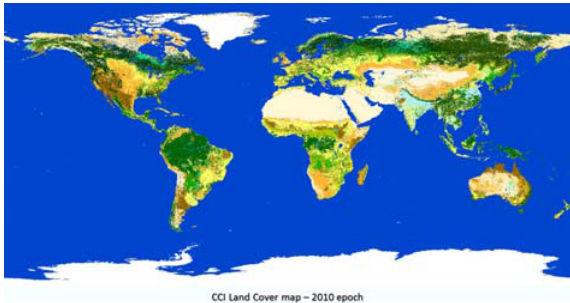
Figure 5. The global CCI-LC map from the 2010 epoch (2008-